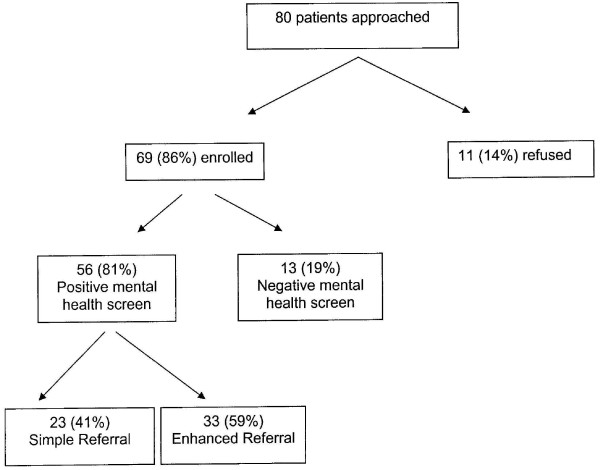
Sampling Schema.